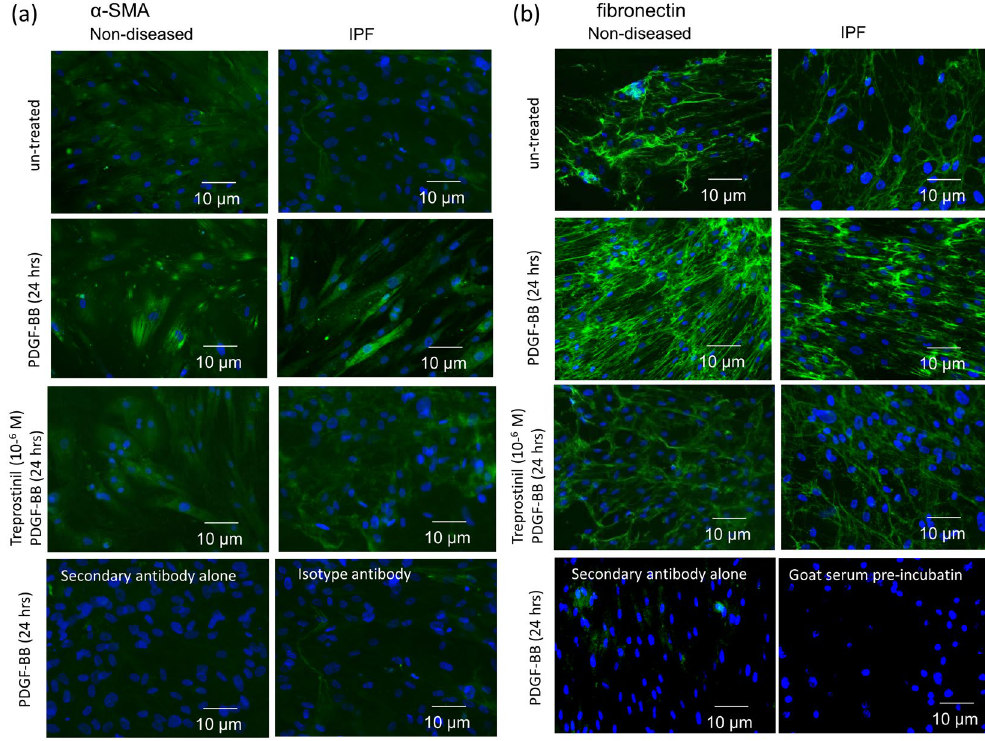
Figure 5. Treprostinil prevents α -SMA and fibronectin deposition and arrangement dose dependently. ( a ) PDGF-BB stimulated total synthesis as well as contractile fibril confirmation of α -SMA within 24 hrs and this was dose dependently reduced by Treprostinil. Fourth row shows images of cells incubated with the secondary antibody alone and with isotype antibodies of the first α -SMA specific antibody. ( b ) PDGF-BB induced fibronectin synthesis and network formation was dose dependently reduced by pre-incubation (30 min) with Treprostinil. Fourth row shows images of cells incubated with the secondary antibody alone and with isotype antibodies of the first fibronectin specific antibody. All pictures are representative for at least 5 additional experiments performed in independent primary